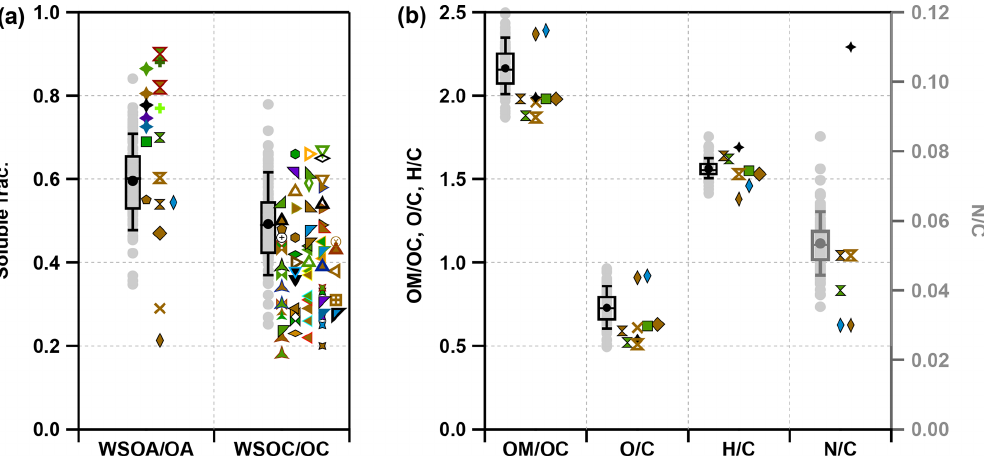
Figure 2. Box and whisker plots of (a) the water-soluble fractions of OA (WSOA / OA) and OC (WSOC / OC) and (b) OM / OC, O / C, H / C and N / C ratios (I-A method) of WSOA. The circles represent the mean values, the horizontal lines represent the 50th percentiles, the lower and upper of the boxes represent the 25th and 75th percentiles, and the lower and upper whiskers represent the 10th and 90th percentiles in this study. Colored markers represent data values from previous references: data are in purple in spring, green in summer, blue in autumn, and brown in winter. The data across the year are in black, and the results of different seasons and different sites in the same reference are shown with the different edge colors. The sources of the data are detailed in the Fig. S10.